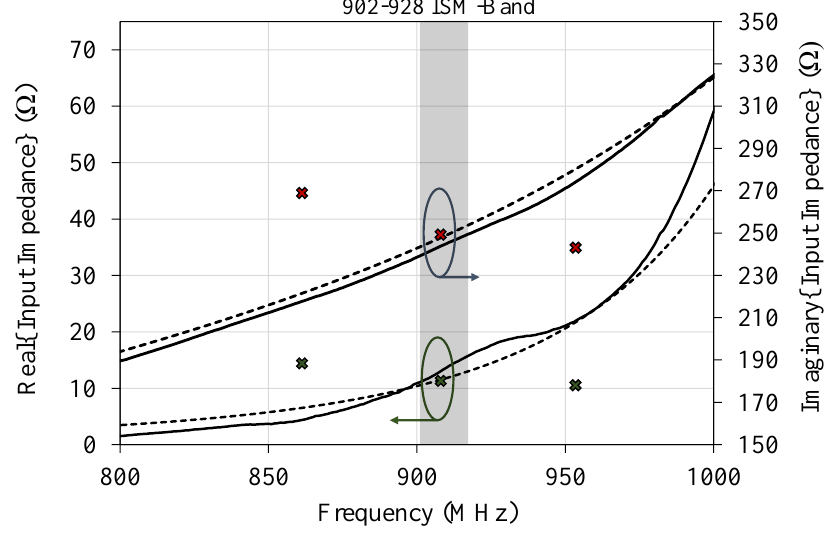
Figure 8. Simulated (CST: dotted line) and measured (solid line) input impedance (real: primary axis, imaginary: secondary axis) of the antenna showing a close match to the chip’s input impedance (shown as discrete points) at 915